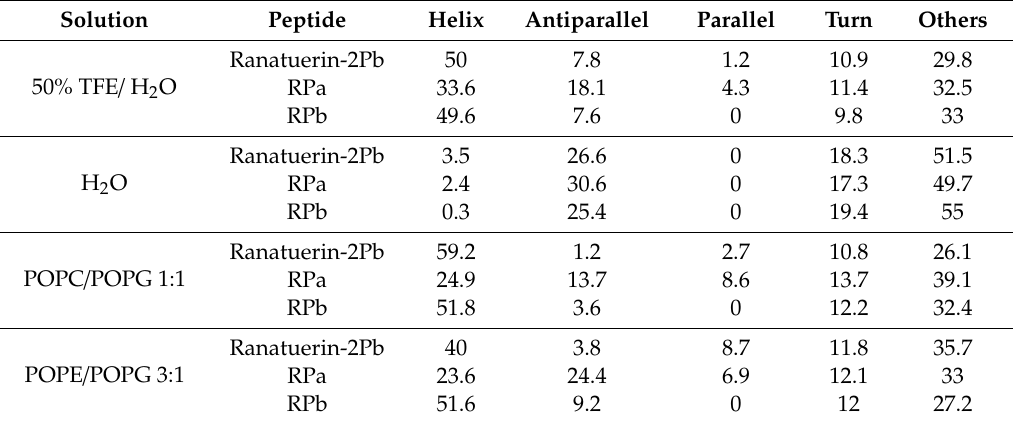
Figure 3. CD spectra record for Ranatuerin-2Pb, RPa and RPb in 50% TFE / H 2 O, H 2 O and LUV liposomes of S. aureus (POPC / POPG 1:1) and E. coli (POPE / POPG 3:1). Table 2. The estimated secondary structure content (%) of Ranatuerin-2Pb, RPa and RPb from obtained CD spectra in di ff erent solutions using BESTSEL CD spectrum analysis